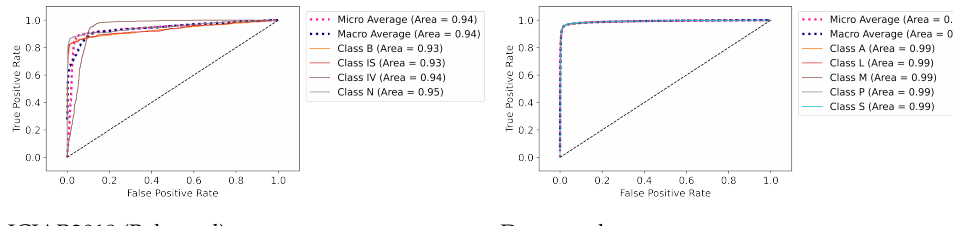
Figure 7. AUC (ROC) curves for the multi-class classification of the ICIAR2018 and Dartmouth datasets. Class labels are according to the abbreviations of Figures 2 and 3 (Best viewed in